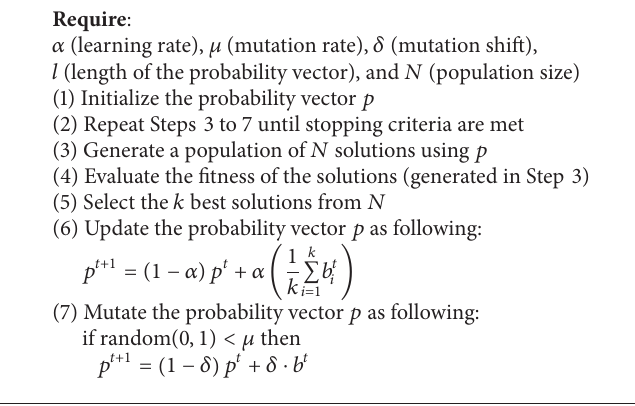
Pseudocode 1: The PBIL